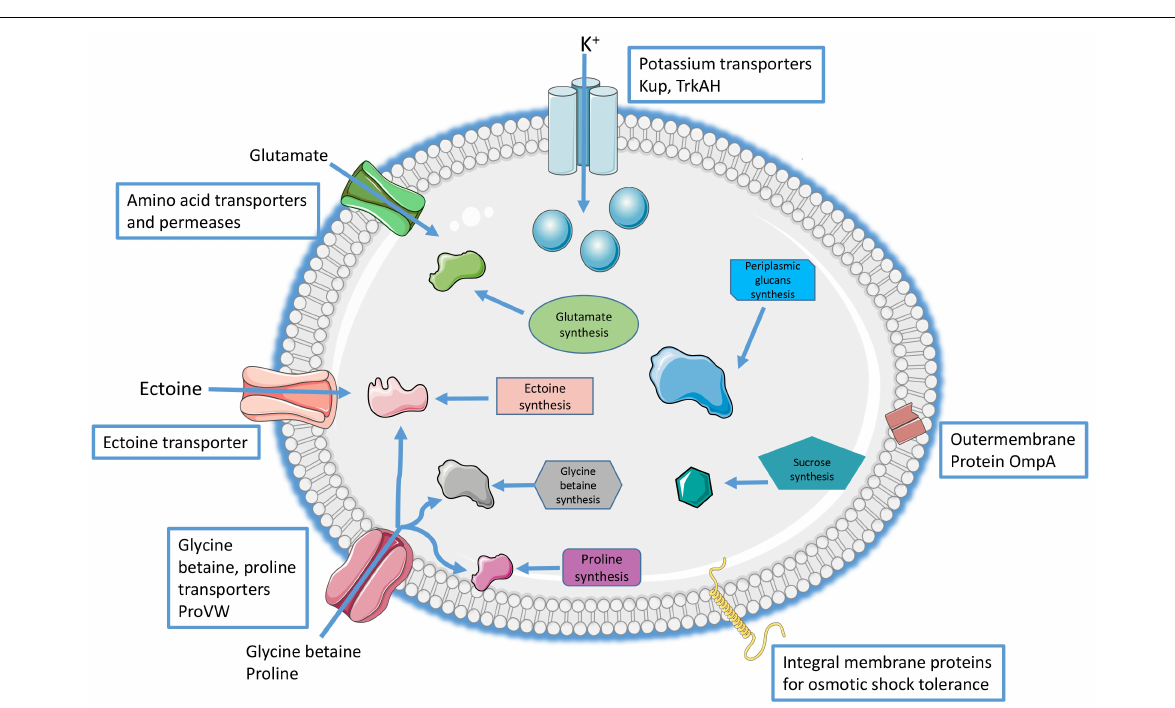
FIGURE 2 | Venn diagram showing the shared and unique genes related to halotolerance in members of the Acidihalobacter genus.